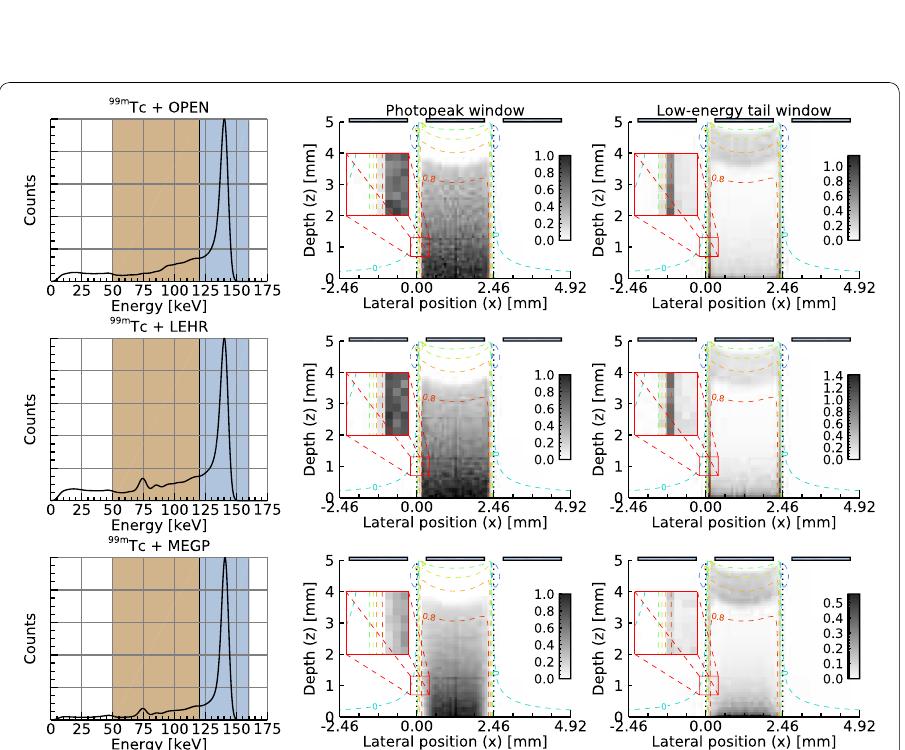
Fig. 5 Simulated 99m Tc spectra for the OPEN, LEHR and MEGP collimators (left column). The spectra are shown alongside interaction distributions of photons contributing to selected intervals over the photopeak and low-energy tail (middle and right columns, respectively). The interaction maps have been scaled such that the photopeak maps (middle column) have values between 0 and 1. The CIE map from Fig. 2 is overlaid on the interaction maps as isocontours. Dotted vertical lines indicate the centre of the anode